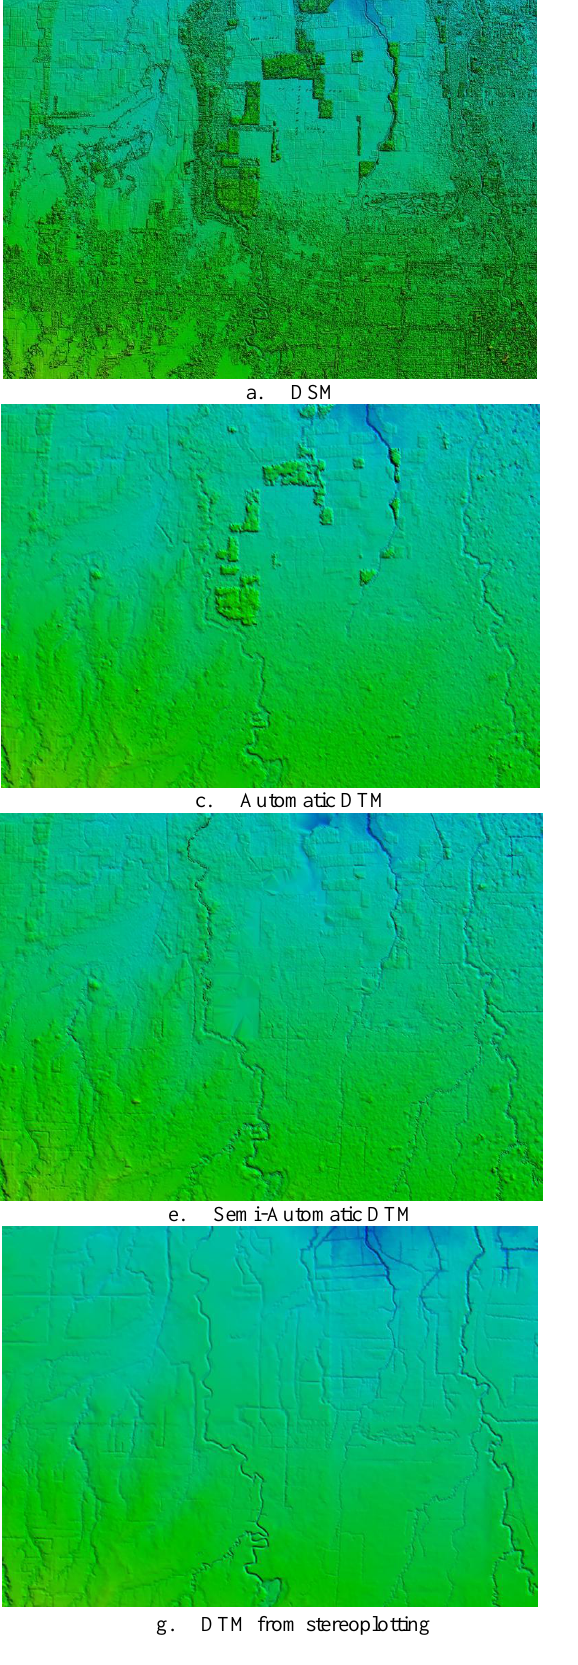
Figure 10. DTM and Contour line